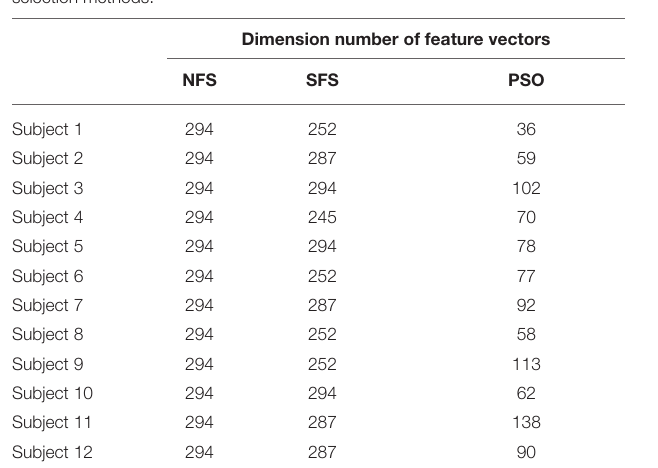
TABLE 1 | Dimension numbers of the feature vectors selected by different feature selection methods.